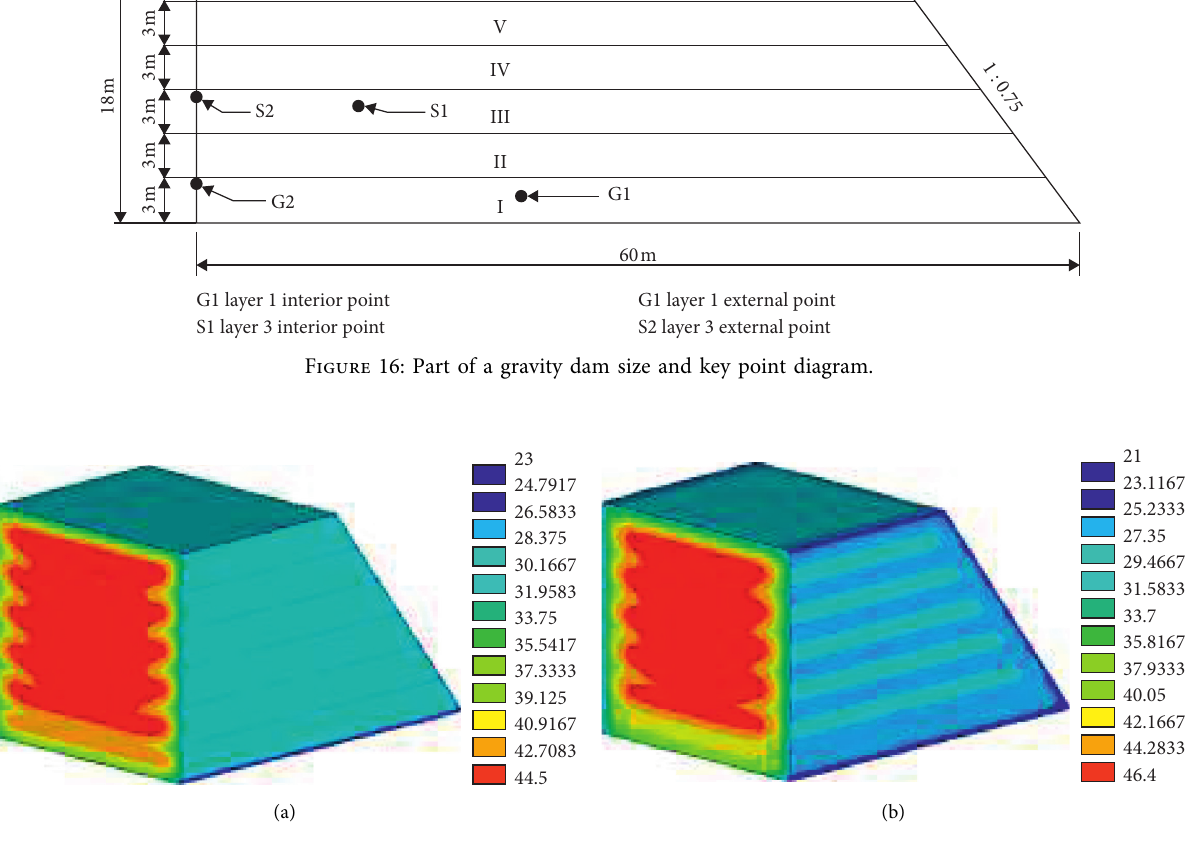
Figure 17: Temperature envelope diagram of BC and IC in vertical flow direction of dam model ( °